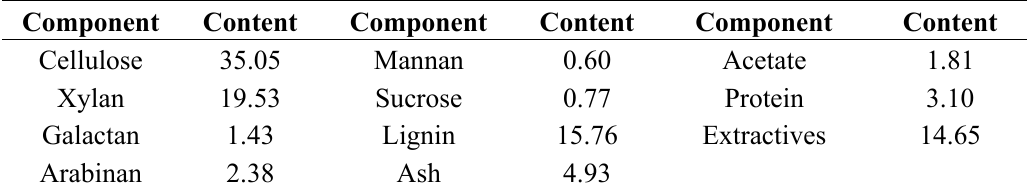
Table 3. Feedstock composition. Unit: dry wt %.